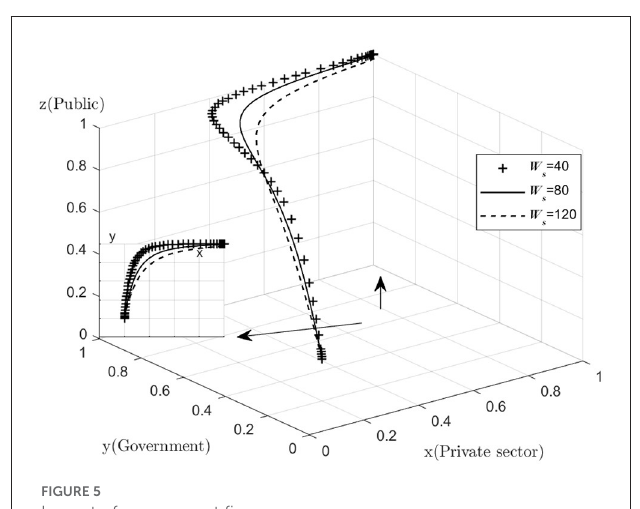
FIGURE7 Impact of additional regulatory